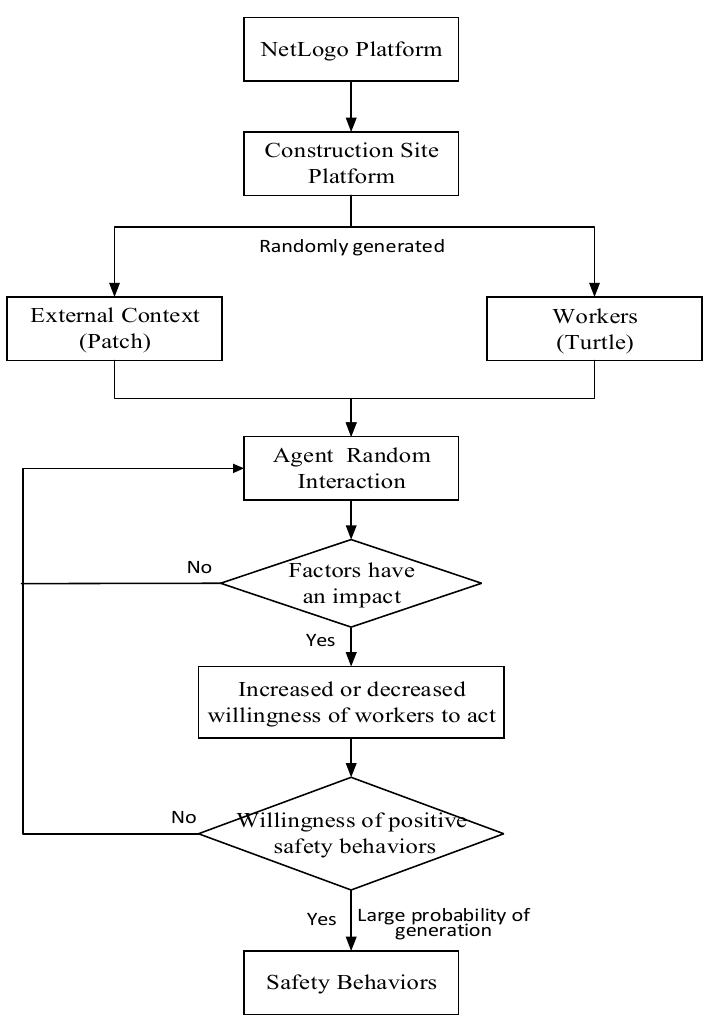
Figure 2. Simulation flow.